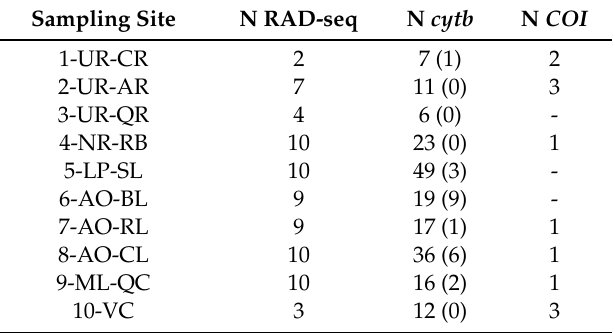
Table 1. Number of specimens analyzed per sampling site using RAD-seq and mitochondrial markers ( cytb and COI